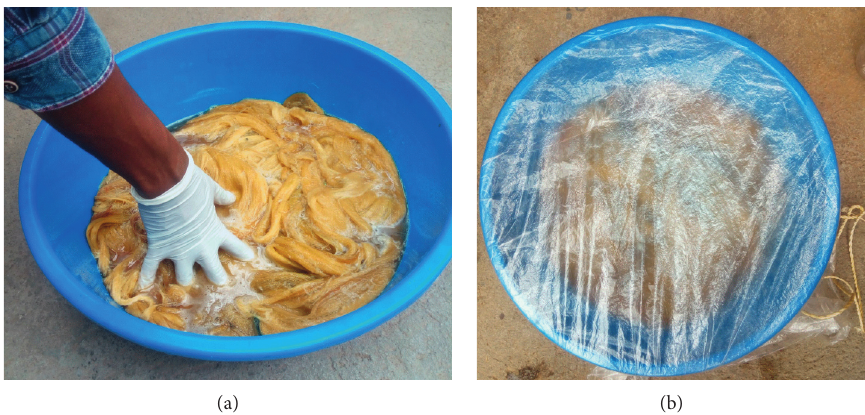
Figure 2: (a) Immersing sisal fiber into 5% NaOH solution; (b) sealing immersed sisal fiber.